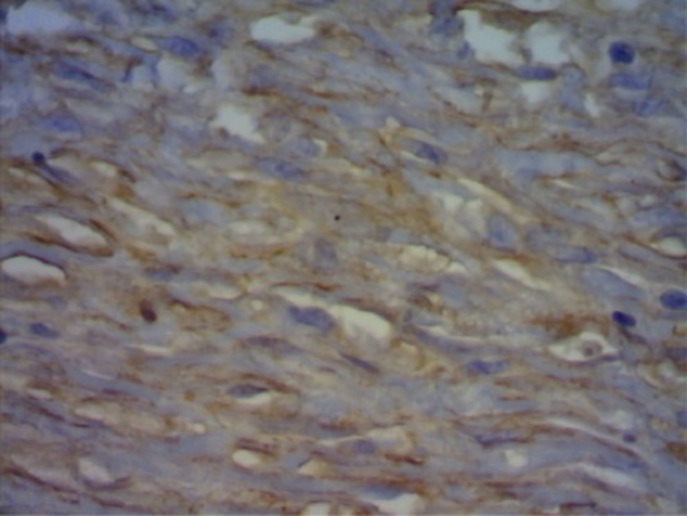
Immunohistochemical staining for control group/14 day subset.